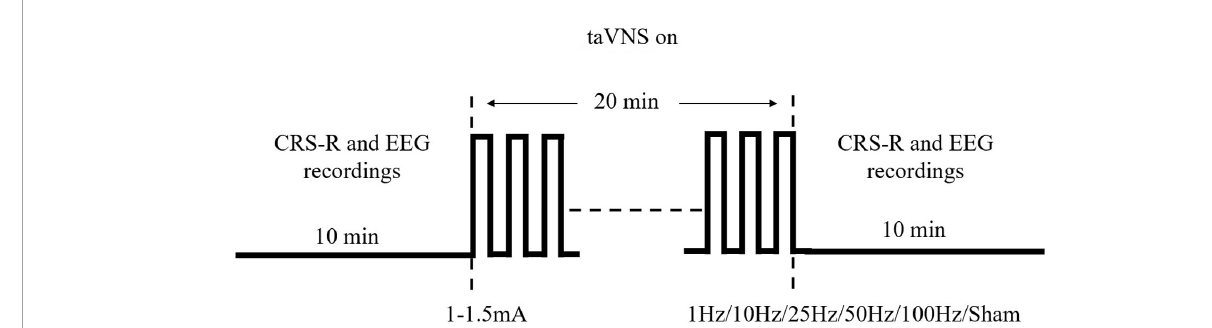
FIGURE1 Single stimulation process and parameters used for stimulation.